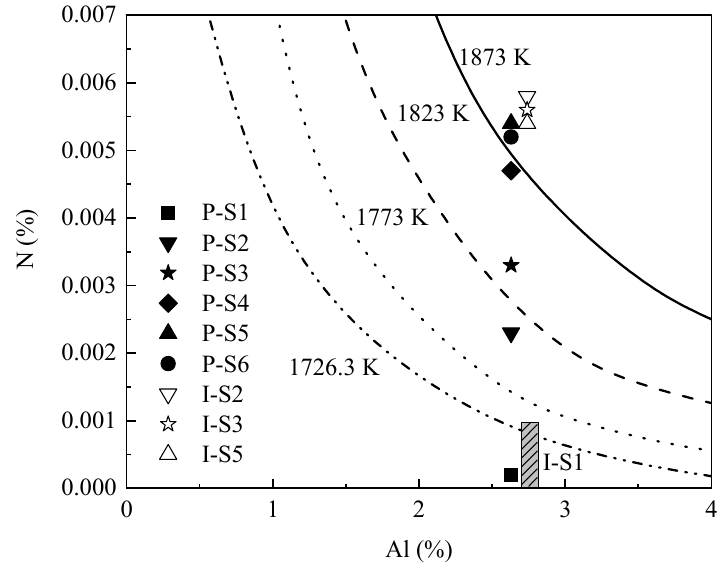
Figure 4. AlN stability diagram for the experimental steel composition of 533N-P and 533N-I, obtained by using FactSage 7.3.